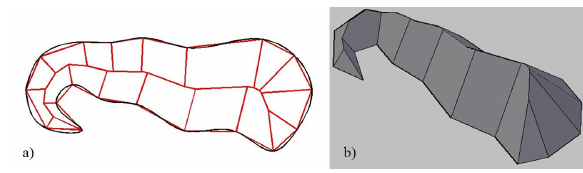
Figure 2: Roof: a) a straight skeleton for a polygon, b) 3D model of the roof (Koźniewski et al., 2013)